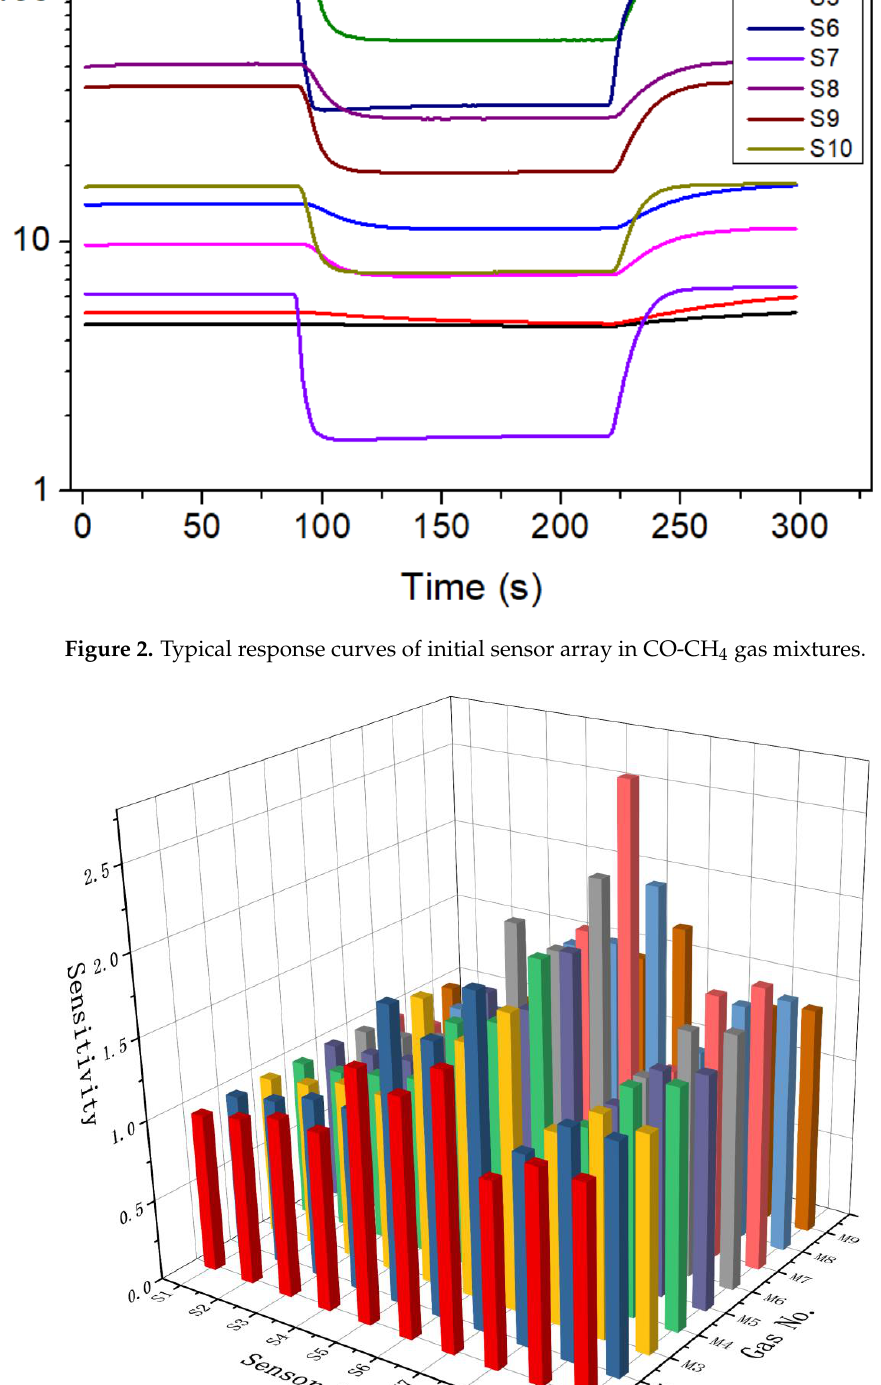
Figure 3. Sensitivities of the initial sensor array to the experimental gas mixtures.